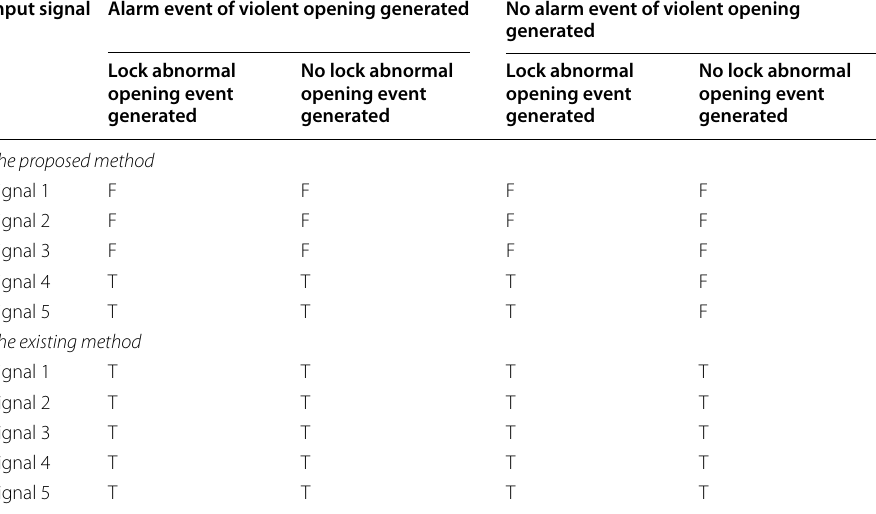
Table 5 Test results of violent opening